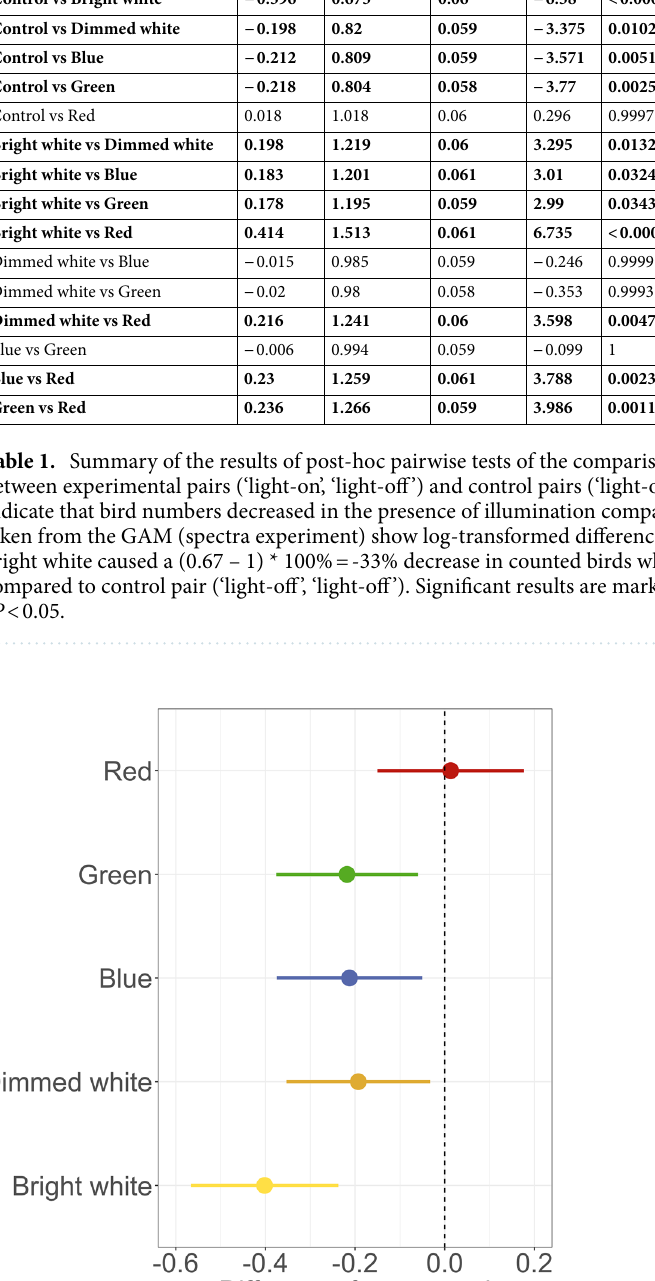
lower number of flying seabirds when using bright white light than dimmed white light. We also counted fewer seabirds when using short compared to long wavelengths, as Manx shearwaters were more repelled by green/ blue than by red light. We expected this interaction between brightness and wavelength, since examination of the retina of closely related species revealed that diving seabirds are more sensitive to blue and green colours than to red, which is probably an adaptation to diving in sea water where the blue green wavelengths (deep sea blue 475 nm) are most effective for observing prey and predators underwater 40, 51 .